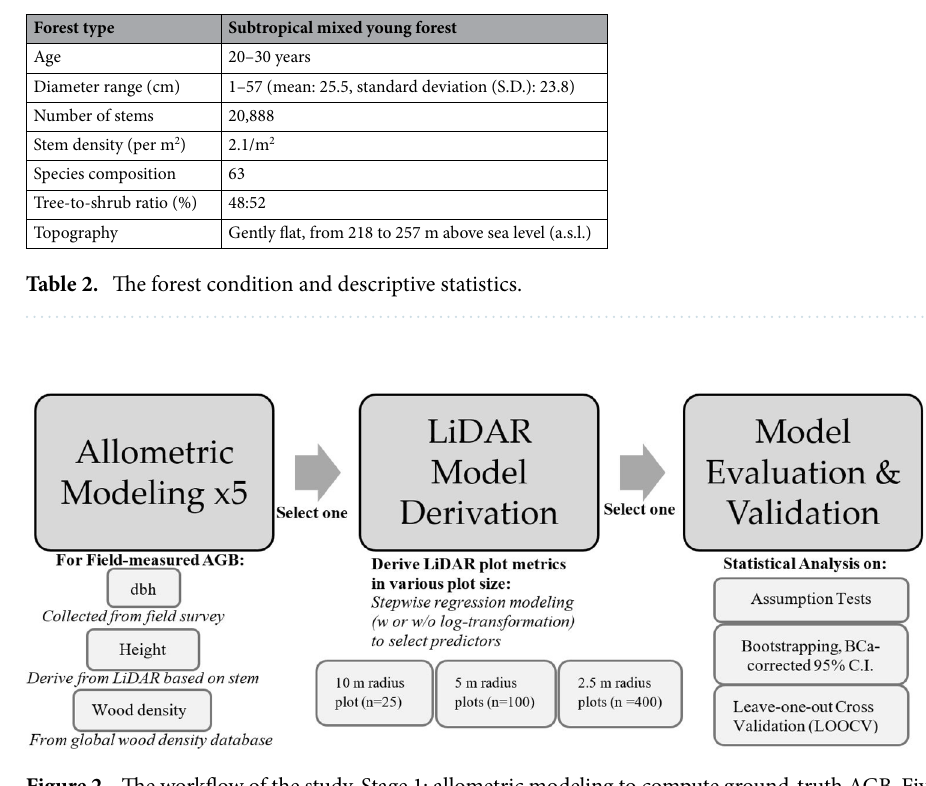
Figure 2. The workflow of the study. Stage 1: allometric modeling to compute ground-truth AGB. Five allometric models were compared and the best one is selected to calibrate model in the next stage. Stage 2: LiDAR AGB Model Derivation, by comparing LiDAR plot metrics derived in different plot size (i.e. 10 m, 5 m, 2.5 m radius). Stage 3: Model Evaluation & Validation on the best model selected from Stage 2 (Source: Authors).